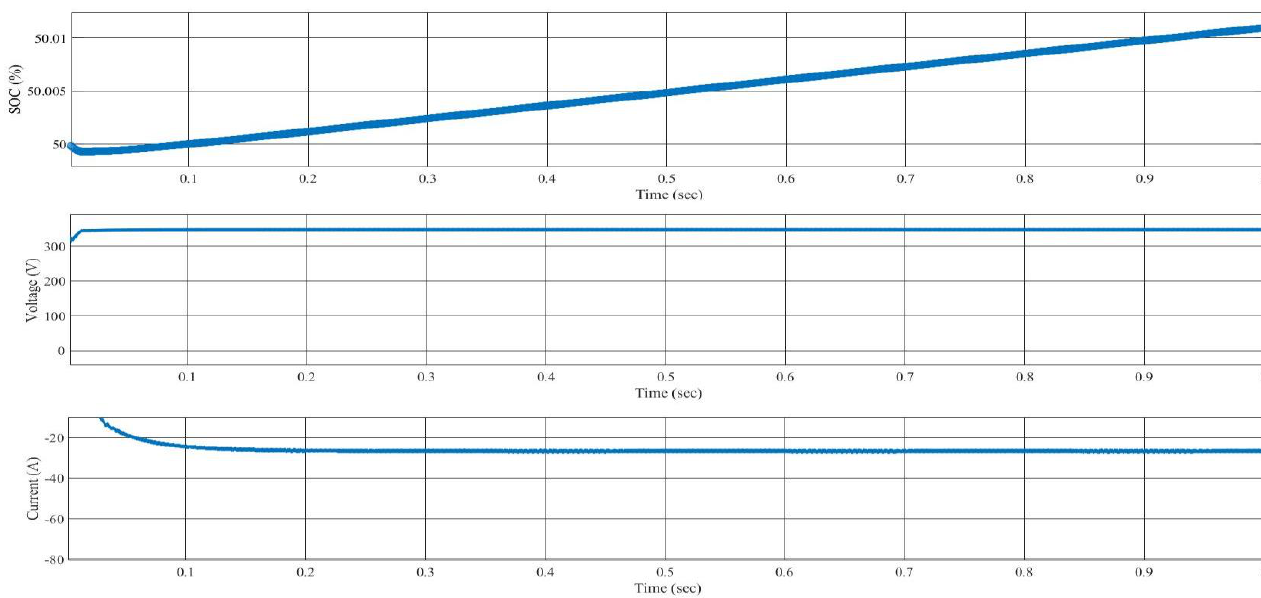
Figure 14 . Charging the EV’s battery from the battery al one. Figure 14. Charging the EV’s battery from the battery